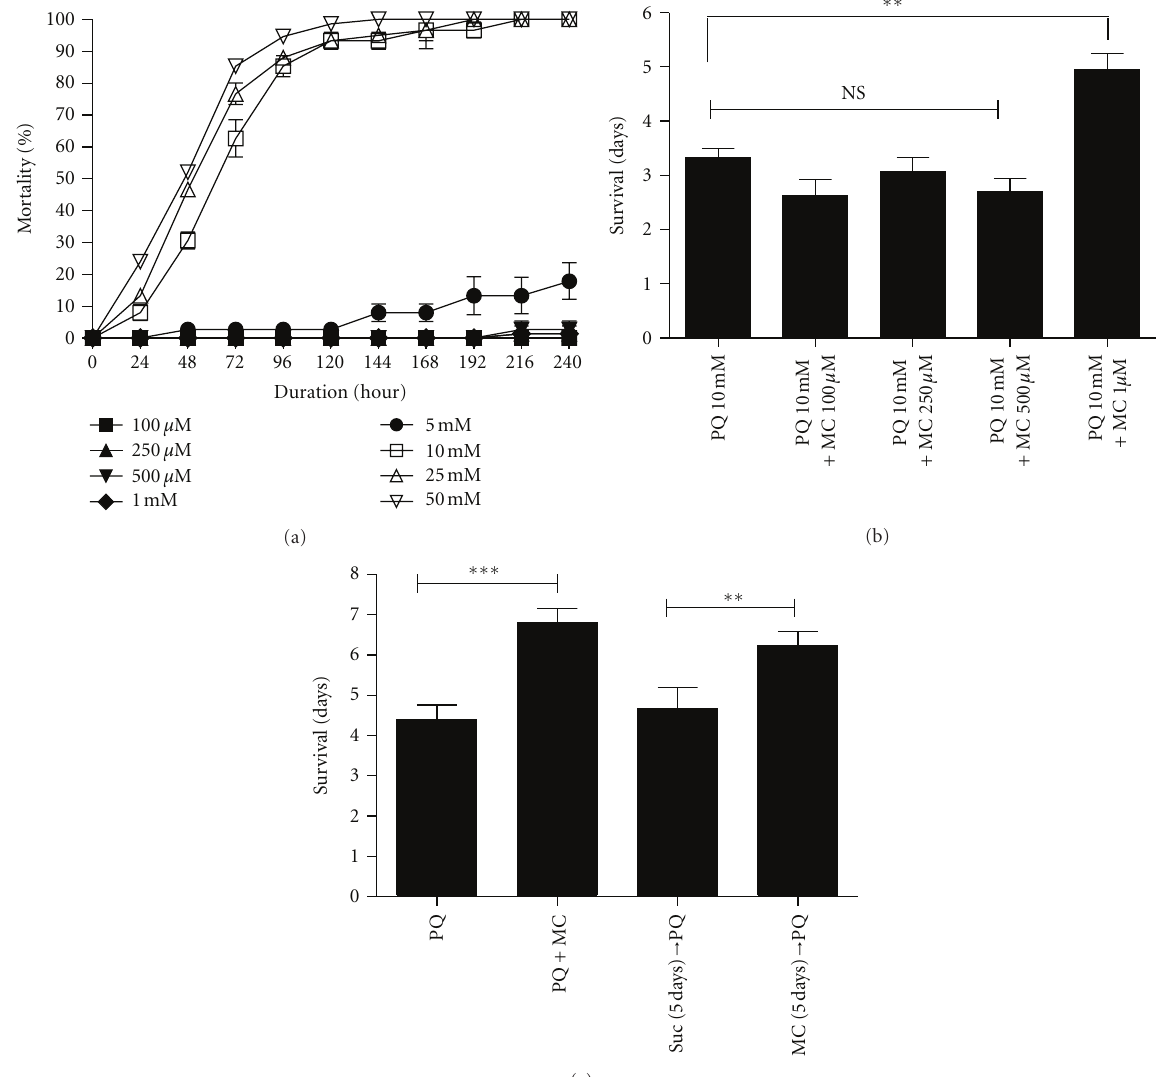
Figure 1: E ff ect of MC in absence and presence of 10mM PQ on survival of adult male flies. (a) E ff ect of increasing concentrations of MC (100 μ M–50mM) on survival of adult male flies. Data were collected every 24 hrs for each group until 100% mortality was noted with 50mM MC. (b) E ff ect of di ff erent doses of MC co-fed with 10 mM PQ on the life span of wild type adult males. Co-feeding of 1mM MC with 10mM PQ significantly extends the survival duration compared with PQ alone. ∗∗ represents the di ff erence between PQ-fed flies and those fed PQ with 1mM MC at P < 0 . 005. NS = nonsignificant. Error bars indicate the standard error of the mean. Each data point was derived at least 10 replications of 15 flies each. (c) Wild type flies at 48hrs after eclosion were fed PQ and/or MC using di ff erent regimens as shown in the graph. The MC co-feeding group was compared to the PQ alone group and the MC prefeeding group was compared with the same aged group prefed 5% sucrose. Both co-feeding and prefeeding regimens improved the survival duration compared to PQ alone. ∗∗ = P < 0 . 005 and ∗∗∗ = P < 0 . 001 and represent the significant di ff erence between PQ and prefeeding and co-feeding groups. Error bars represent SEM, and n = 50–60 flies for all groups in (a), (b), and